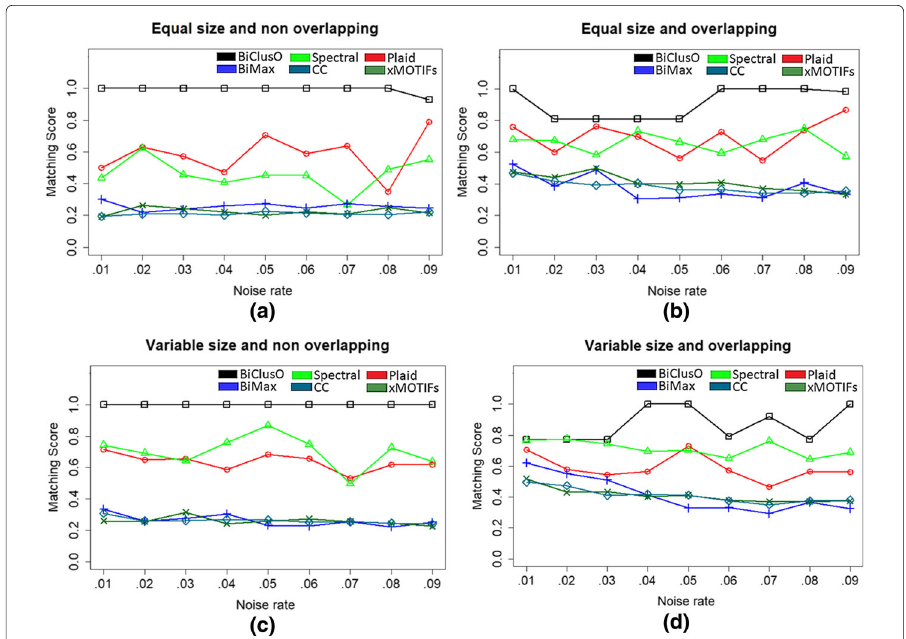
Fig. 8 Performance of different algorithms in terms of average cluster relevance on synthetic data